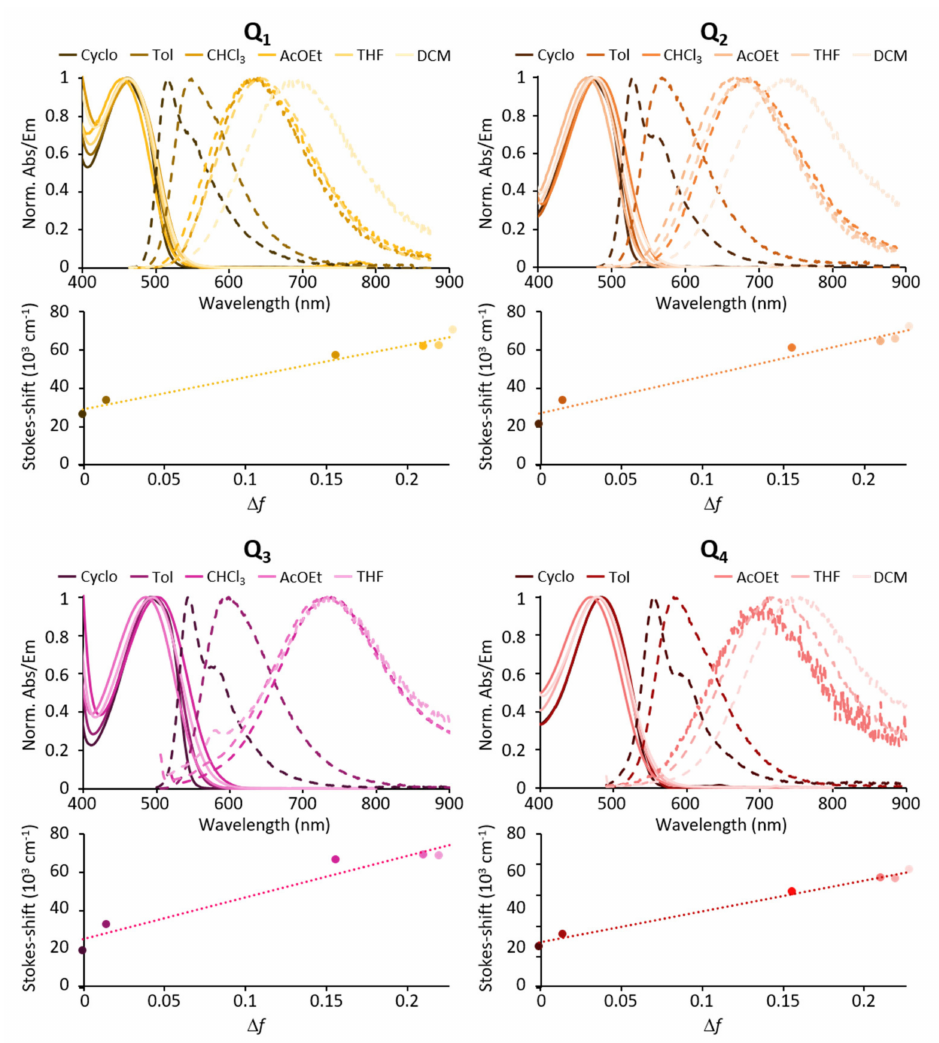
Figure 3. Solvatochromic behaviour of dyes Q1 – Q4